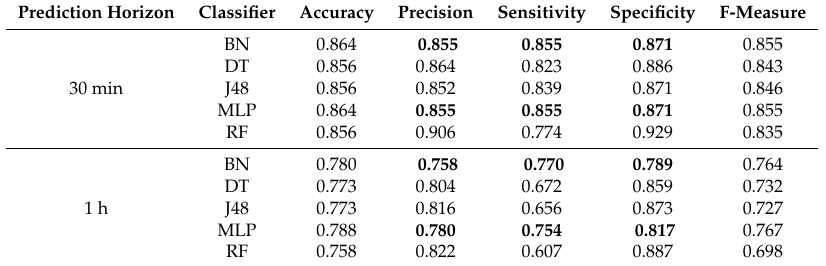
Table 4. Precision, sensitivity, specificity and F-Measure of evaluated classifiers on Site 1 dataset. Prediction Horizon Classifier Accuracy Precision Sensitivity Specificity F-Measure